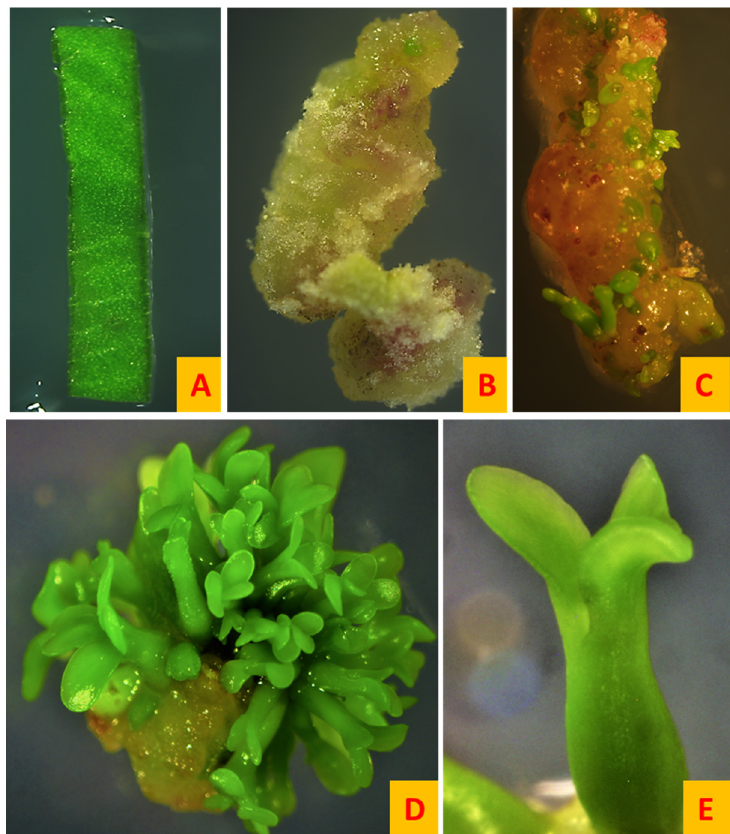
Figure 4. Somatic embryogenesis on the B5h-B5 system. ( A ) Inoculation of the leaf layer explant on the B5h medium, ( B ) complete callus formation after 18 d on the B5h medium, ( C ) induction of somatic embryos after seven days on the B5 medium, ( D ) synchronous culture of mature somatic embryos after 21 days on the B5 medium and ( E ) mature cotyledonary stage embryo ready to be harvested after 21 days on the embryo maturation medium. All images were at 8× magnification except Image E (24×). Table 1. Number of somatic embryos formed at weekly intervals on the embryo development and maturation (EDM) medium in all